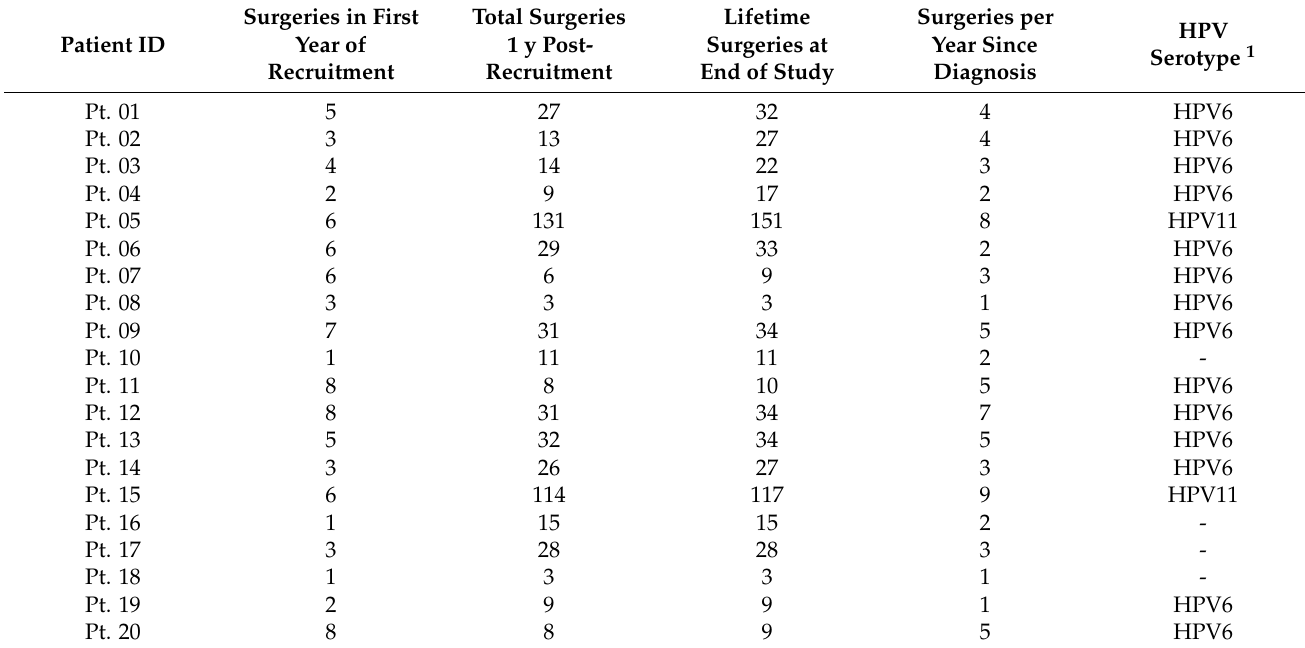
Table 3. Outcomes calculated at end of the study